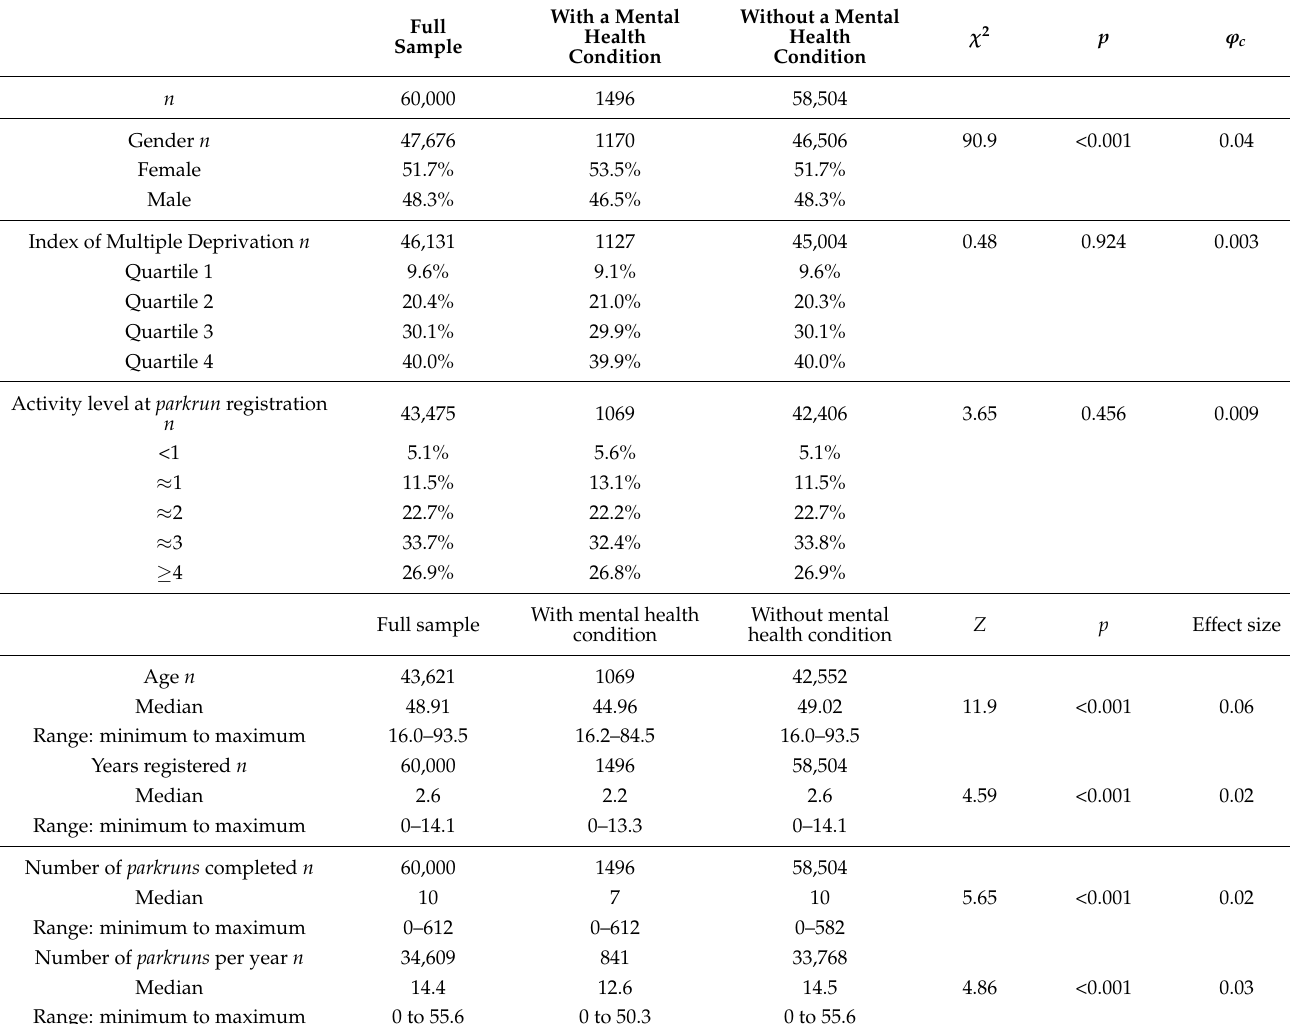
Table 1. Demographics for the Health and Wellbeing Survey respondents at the time of the survey distribution (29th October to 3rd December 2018).